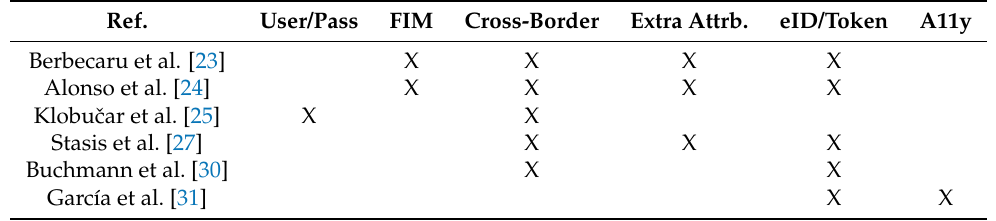
Table 9. Comparison with related work. FIM, Federated Identity Management.